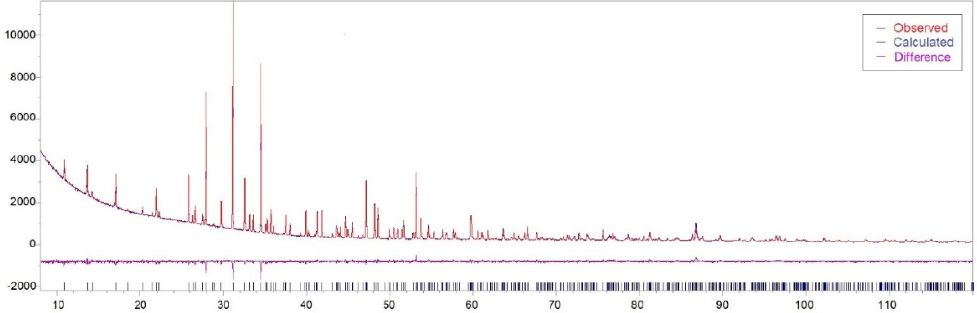
Figure 2. Rietveld plot of Ni β –TCP phase: Observed diffraction profile (blue line), calculated profile (red line), and difference profile (violet line).